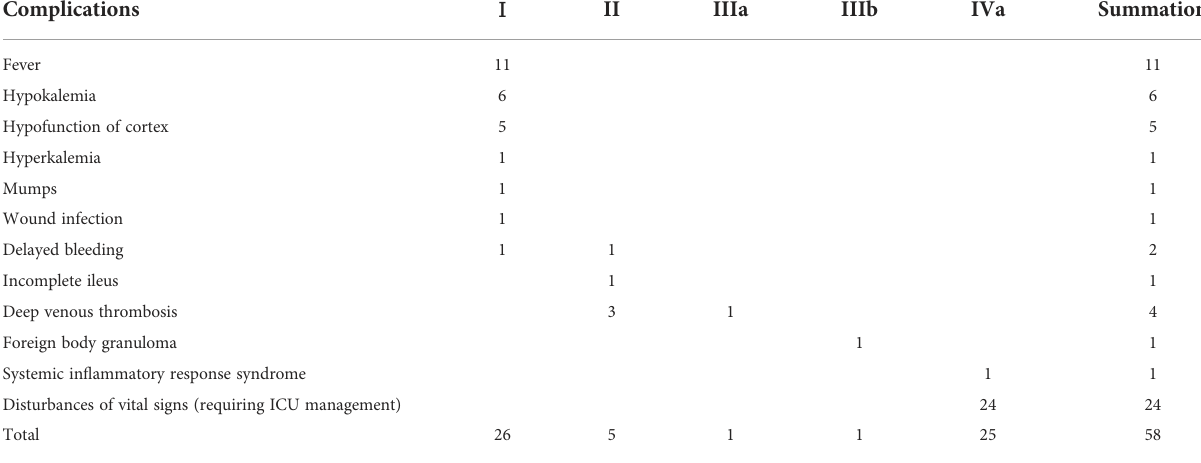
TABLE 2 Classi fi cation of